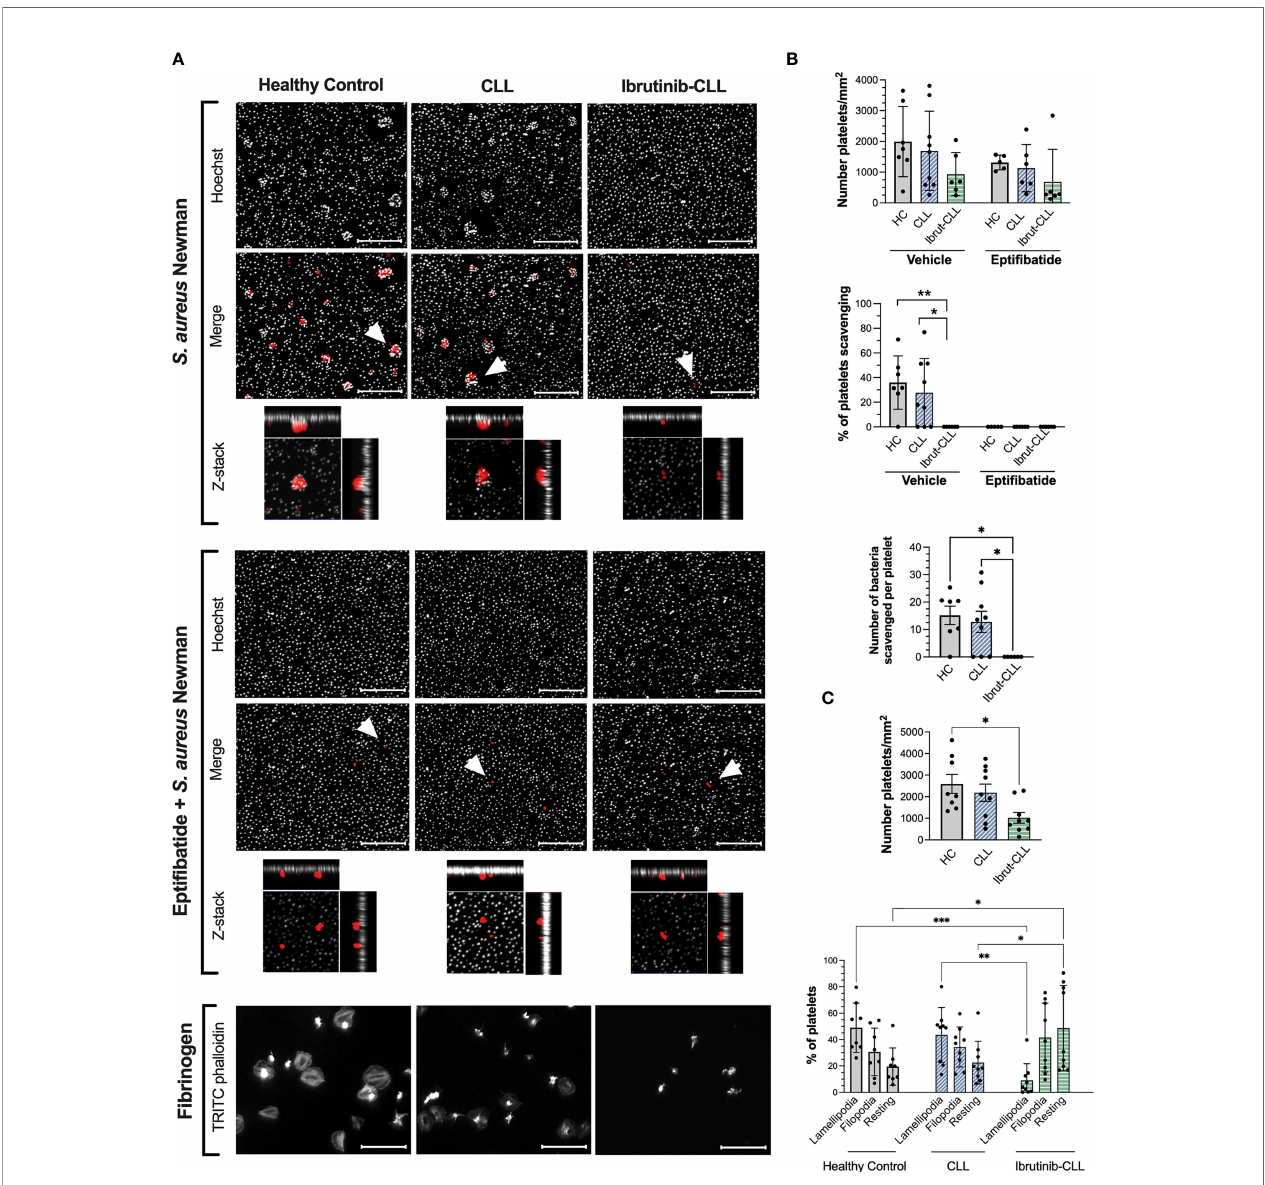
FIGURE 2 | S. aureus Newman can be scavenged by platelets from ibrutinib-untreated but not ibrutinib-treated CLL patients. PRP samples from healthy controls, ibrutinib-untreated CLL and ibrutinib-treated CLL were adjusted to 2 x10 7 platelets/ml and 15% autologous plasma. Samples were incubated with epti fi batide (9 m M) to inhibit integrin a IIb b 3 or vehicle for 2 minutes and incubated for 1 hour with S. aureus Newman or fi brinogen immobilized on glass coverslips. Coverslips were then washed, fi xed, permeabilized, and stained with Hoechst 33342 (grey color, bacteria staining) and TRITC phalloidin (red color, platelet staining). Coverslips were mounted and visualized by fl uorescence microscopy. (A) Representative images are presented, with scale bars showing 20 m m. For S. aureus Newman, arrowheads indicate examples of clusters of bacteria scavenged by platelets, and maximum projections of Z-stack images of individual platelets are included. (B) Platelet interactions with S. aureus Newman. Graphs show number of platelets per surface area (top panel), the percentage of platelets scavenging bacteria (middle panel) and the number of bacteria per cluster (bottom panel). Number of samples per clinical group were as follows: healthy controls, n=7 vehicle and n=5 epti fi batide; CLL, n=9 vehicle and n=6 epti fi batide; ibrutinib-treated CLL, n=6 for both vehicle and epti fi batide. (C) Platelet spreading on immobilized fi brinogen. Graphs show number of platelets per surface area and percentage of platelets with fi lopodia ( fi nger-like cellular protrusions) and lamellipodia (laterally extended protrusions characteristic of later stages of spreading). Healthy controls, n=8; CLL, n=9, ibrutinib-CLL, n=9. All data is shown as mean ± SD. Statistical signi fi cance was calculated using one- way or two-way ANOVA followed by Tukey ’ s multiple comparison correction (*p ≤ 0.05, **p ≤ 0.01, ***p ≤